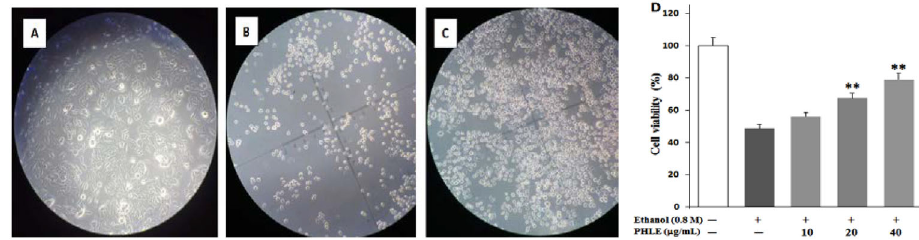
Figure 2. P. hydropiper extract (PHLE) enhanced the viability of GES-1 cells. A , normal group; B , ethanol group; C , PHLE (40 m g/mL) group. Cells were pretreated with various concentrations of PHLE for 12 h followed by stimulation with 7% ethanol for 4 h. D , Cell viability was determined by CCK-8 assay. Data are reported as means ± SD (n=6). **P o 0.01 compared to the ethanol group (ANOVA and LSD post hoc